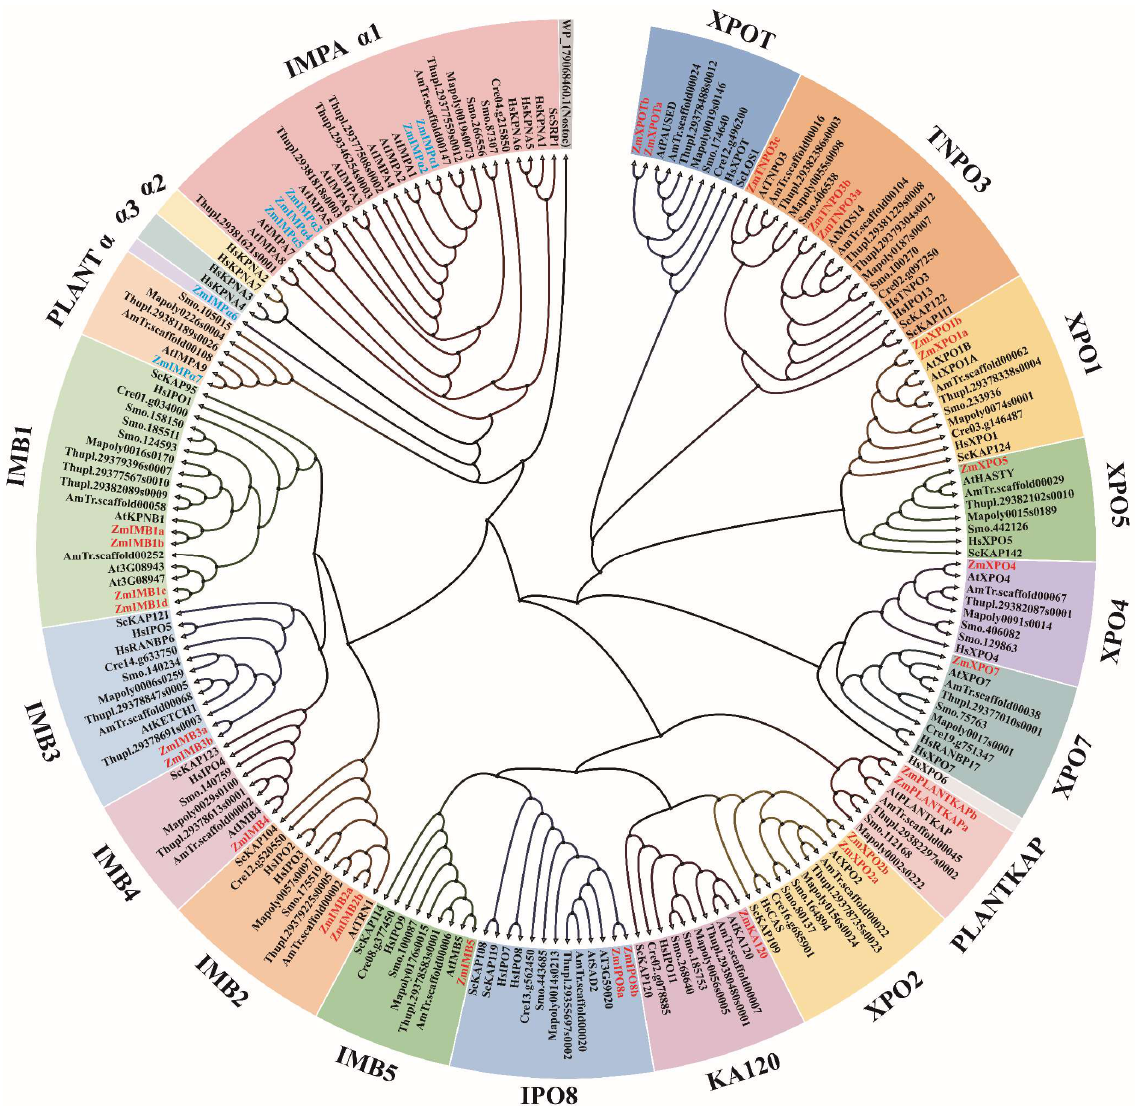
Figure 1. Phylogenetic tree of the Karyopherin superfamily. Based on validated members of the IMPα and IMPβ families from yeast, humans, and Arabidopsis , each protein sequence was used as a query to perform BLASTP searches in Phytozome v13 (https://phytozome-next.jgi.doe.gov/ (accessed on 4 October 2022)), NCBI (https://www.ncbi.nlm.nih.gov/ (accessed on 4 October 2022)), and MaizeGDB (https://www.maizegdb.org/ (accessed on 4 October 2022)), remove the non-representative splicing forms of the same gene locus, and confirm sequences of non-redundant candidates by phylogenetic analysis with the homologous series of the other species. Saccharomyces cerevisiae (Sc), Homo sapiens (Hs), Chlamydomonas reinhardtii (Cre), Marchantia polymorpha (Mapoly), Selaginella moellendorffii (Smo.), Thuja plicata (Thupl.), Amborella trichopoda (AmTr.), Arabidopsis thaliana (At), Zea mays (Zm); ZmIMPα proteins in blue font and ZmIMPβ in red. Results ultimately identified seven IMPαs and twenty-seven IMPβs in maize, named based on their subfamily affiliation (Table 1). In comparison to Amborella trichopoda and Arabidopsis , the members of maize KAPs undergo family expansions, especially in the IMPβ family. The lineage of maize experienced a tetraploidy period combined with two genomes, the Maize1 and Maize2, accompanied by whole genome duplication (WGD) [29,30]. As shown in Supplementary Materials Table S2, sixteen of thirty-four KAP genes